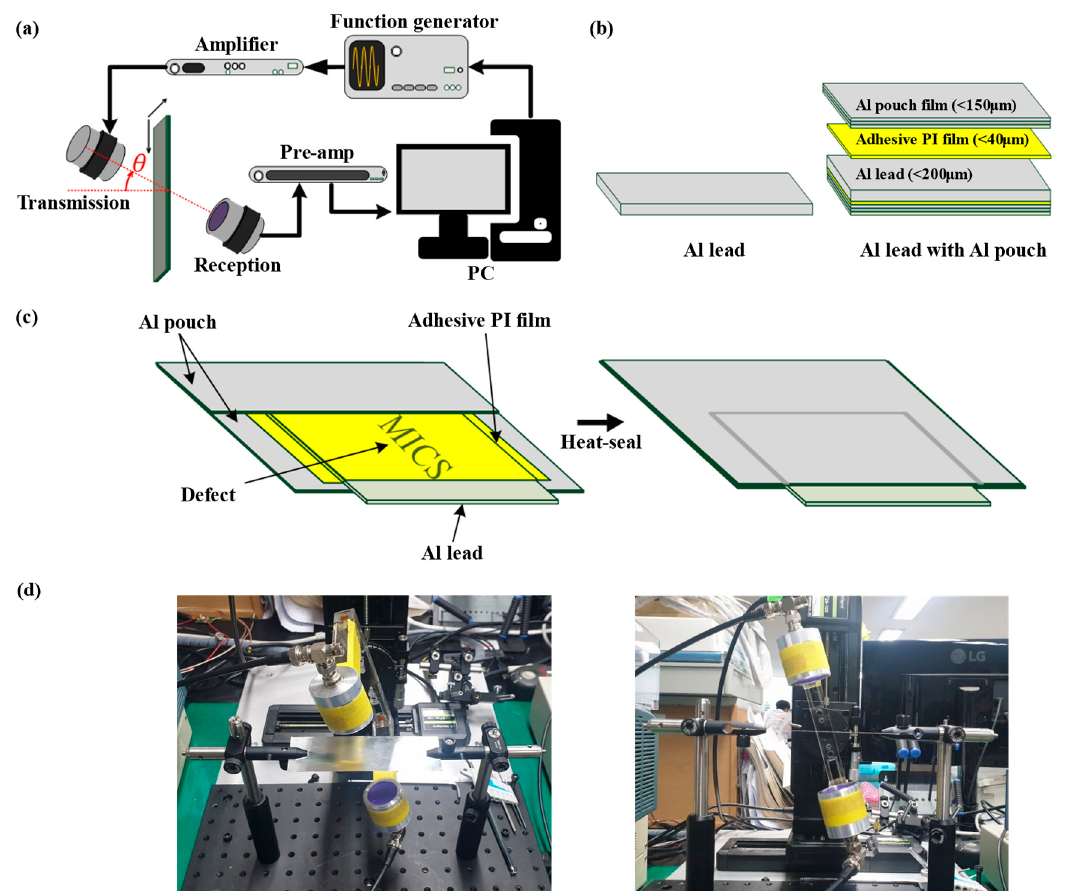
Figure 2. ( a ) The experimental setup of the air-coupled ultrasonic NDT method. ( b ) The test pieces used in the experiment. From the left, the Al lead tab, and the Al lead tab sealed with the Al pouch film and adhesive polyimide (PI) film. These structures are all symmetrical. ( c ) The inhouse Li-ion pouch battery defect model in which a 1-mm piece of paper was inserted as a foreign material. ( d ) Photographs of the experimental setup.